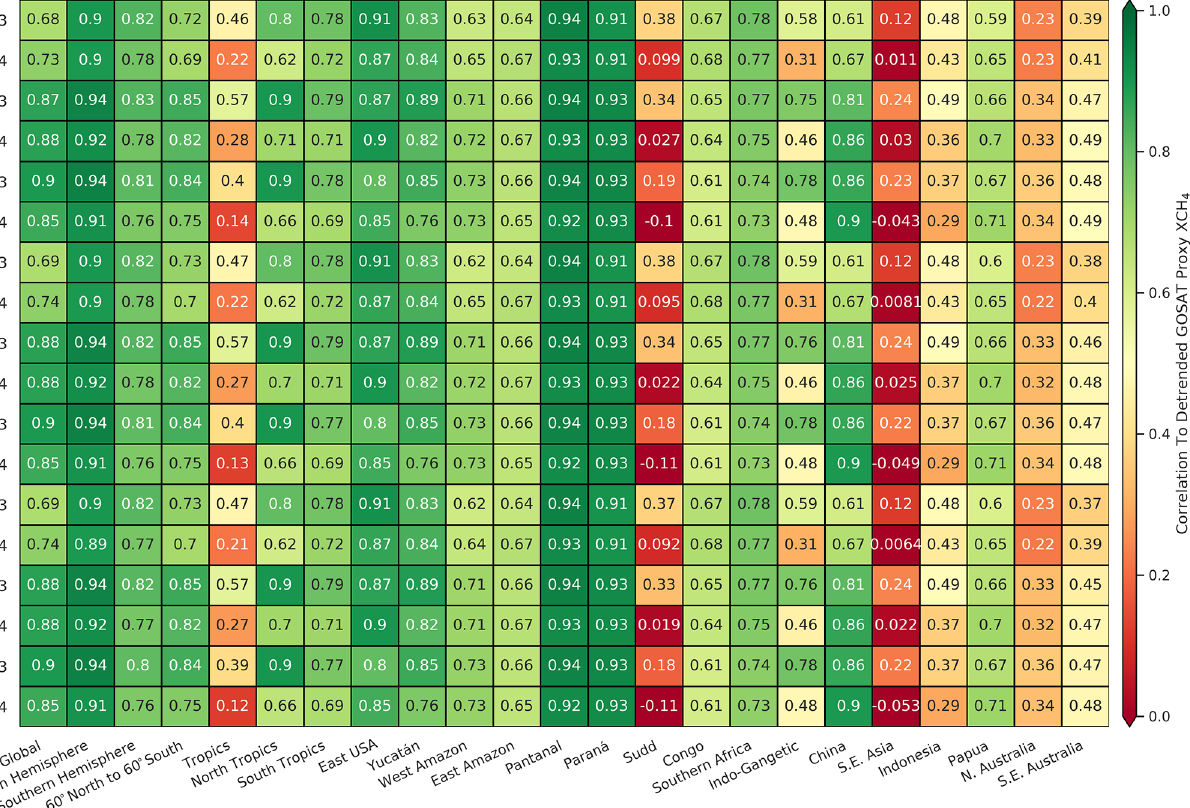
Figure A1. Table showing the correlation coefficients between the modelled and observed seasonal cycle for all regions for every ensemble